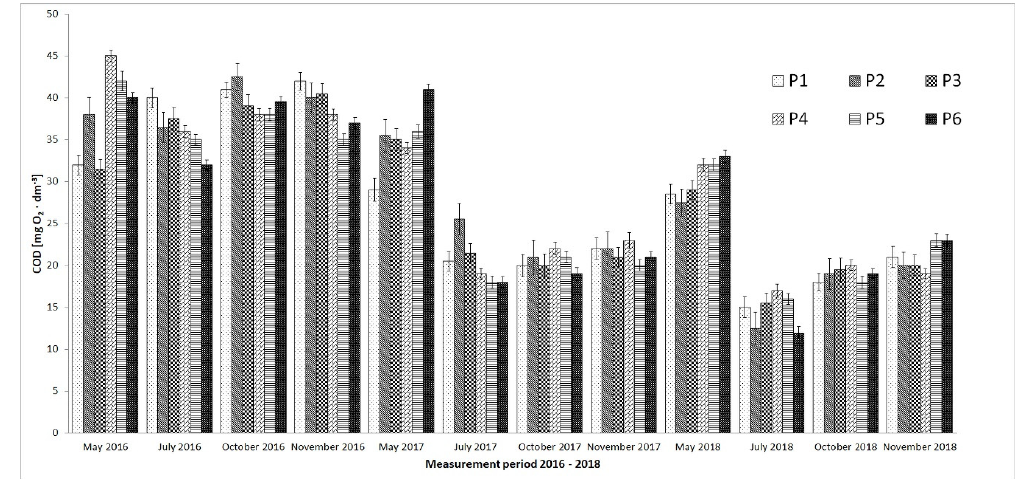
Figure 8. Changes in COD (Chemical Oxygen Demand) value at points P1–P6 in the reservoir. Measurement campaigns 2016–2018.